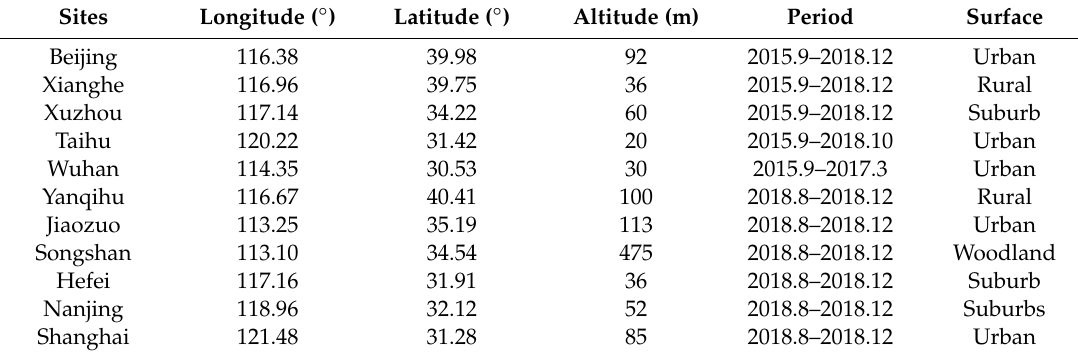
Figure 2. Study area and locations of sites. The cyan-blue rectangle in the left panel represents the eastern China region and the colored dots in the right panel show the locations of eleven ground sunphotometer sites. Table 1. Information about the eleven ground sunphotometer